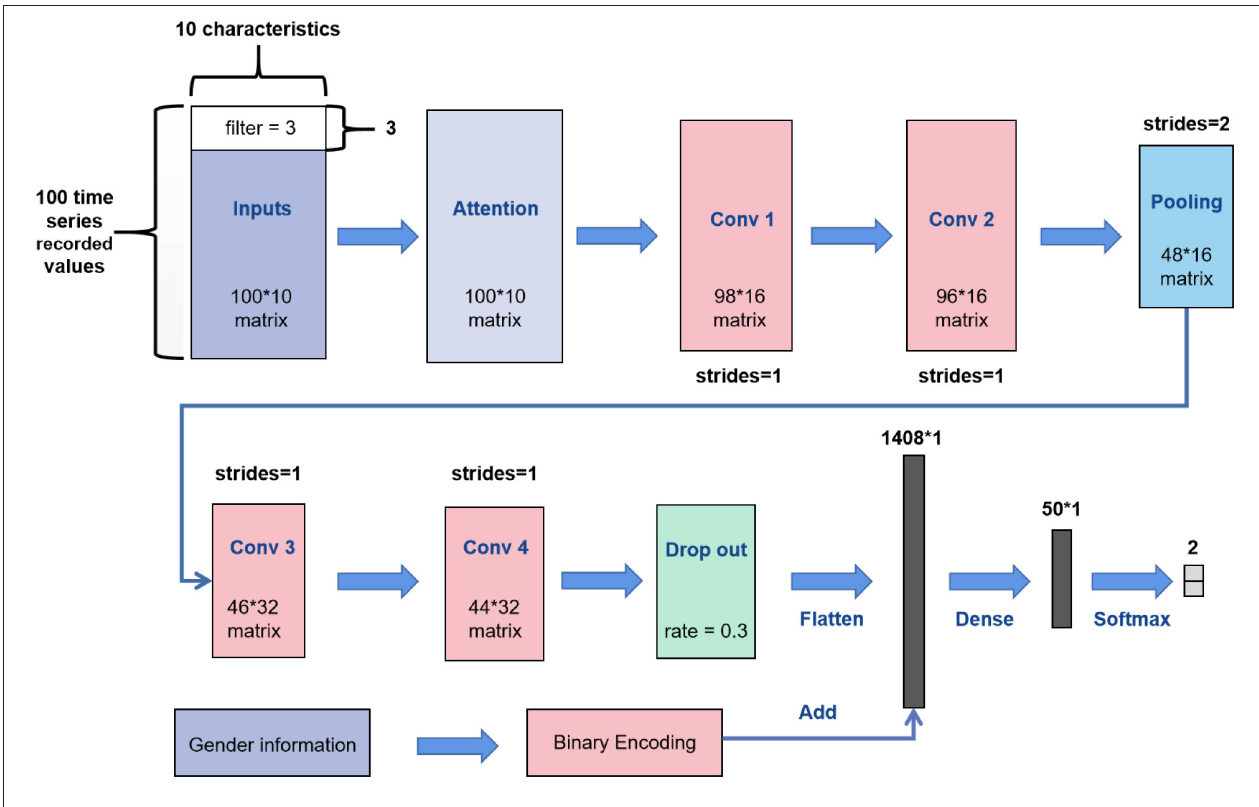
FIGURE 3 | Overall framework of the 1D CNN.